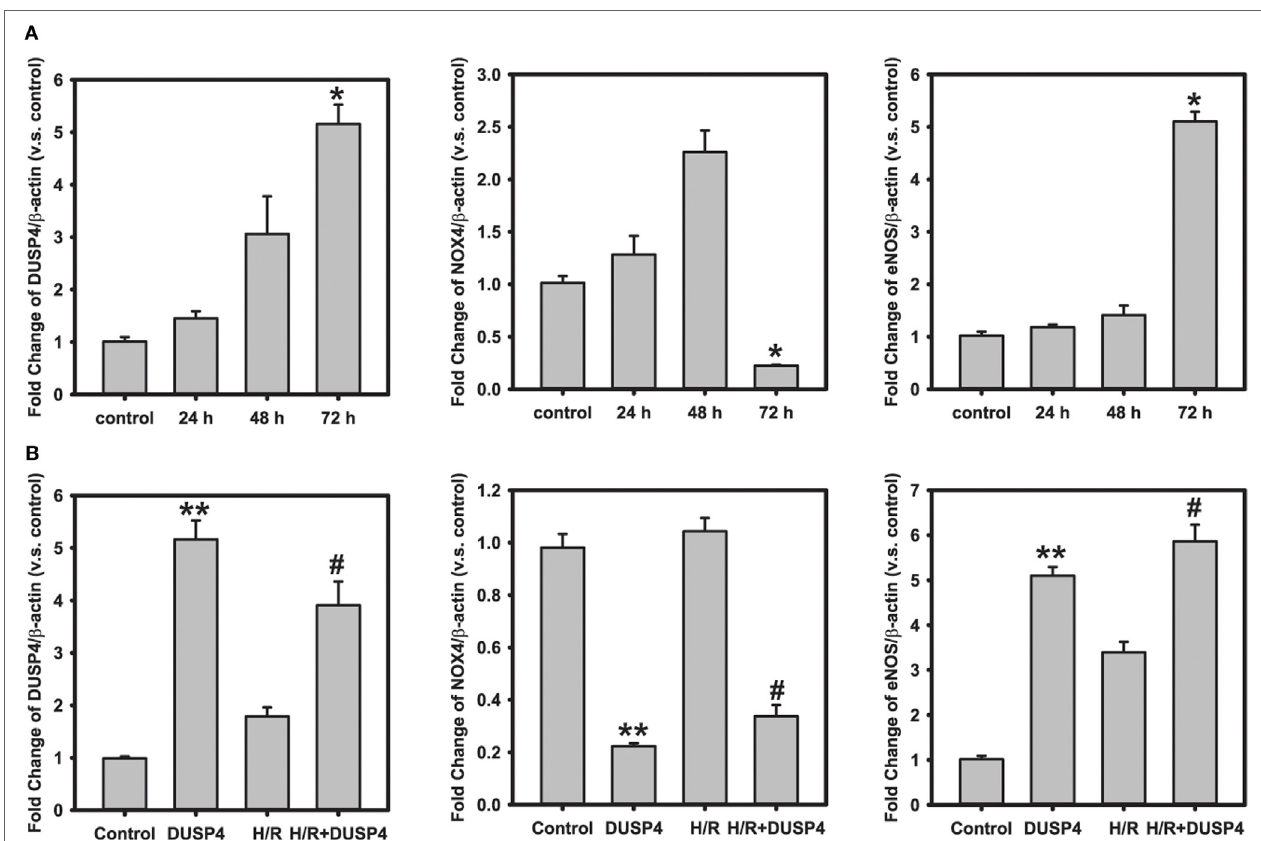
FigUre 5 | Quantitative Pcr analysis of gene expression . (a) Time course of gene analysis: dual-specificity phosphatase 4 (DUSP4) overexpression downregulates NOX4 gene expression (0.22 ± 0.01 versus control; * P < 0.001) 72 h post-transfection. However, the overexpression of DUSP4 upregulates eNOS expression (5.10 ± 0.19 versus control; * P < 0.001) at the end of 72 h of expression. (B) H/R treatment. After 1 h hypoxia and 30 min reoxygenation treatment, DUSP4 overexpression represses NOX4 gene expression (0.34 ± 0.04 versus control), thus reducing the oxidative stress. Upregulation of eNOS expression (5.84 ± 0.37 versus control) by DUSP4 increases NO generation as seen in Figure 4B , thus providing a survival mechanism against H/R-induced oxidant stress. **versus control and # versus H/R; P < 0.001. Data are expressed as mean ± SEM, n ≥